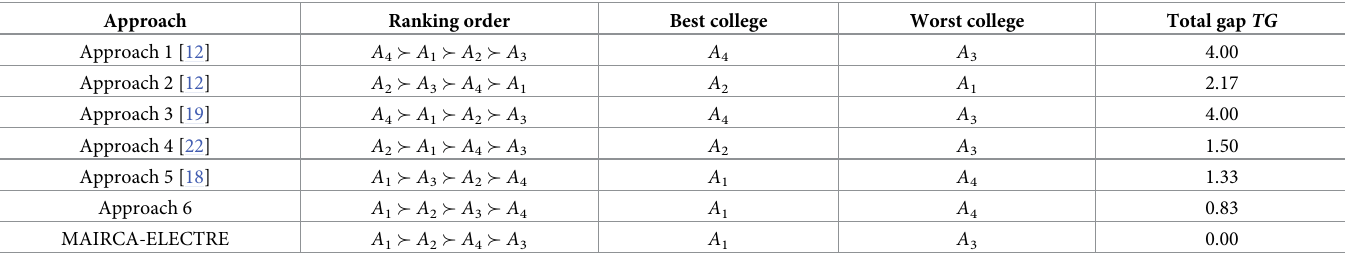
Additionally, Approach 1 and 2 are based on different aggregation operators of PFNs. In this case, some evaluation information may be lost or distorted during the aggregation process. Although Approach 5 can tackle non-compensatory criteria, its average solutions are calcu- lated using aggregation operators in the difference matrix construction process with the EDAS method. In this case, it may not avoid the information loss or distortion problem. Overall, results show that the proposed MAIRCA-ELECTRE approach is feasible and the most appro- priate among these approaches. Table 10. Ranking orders with different